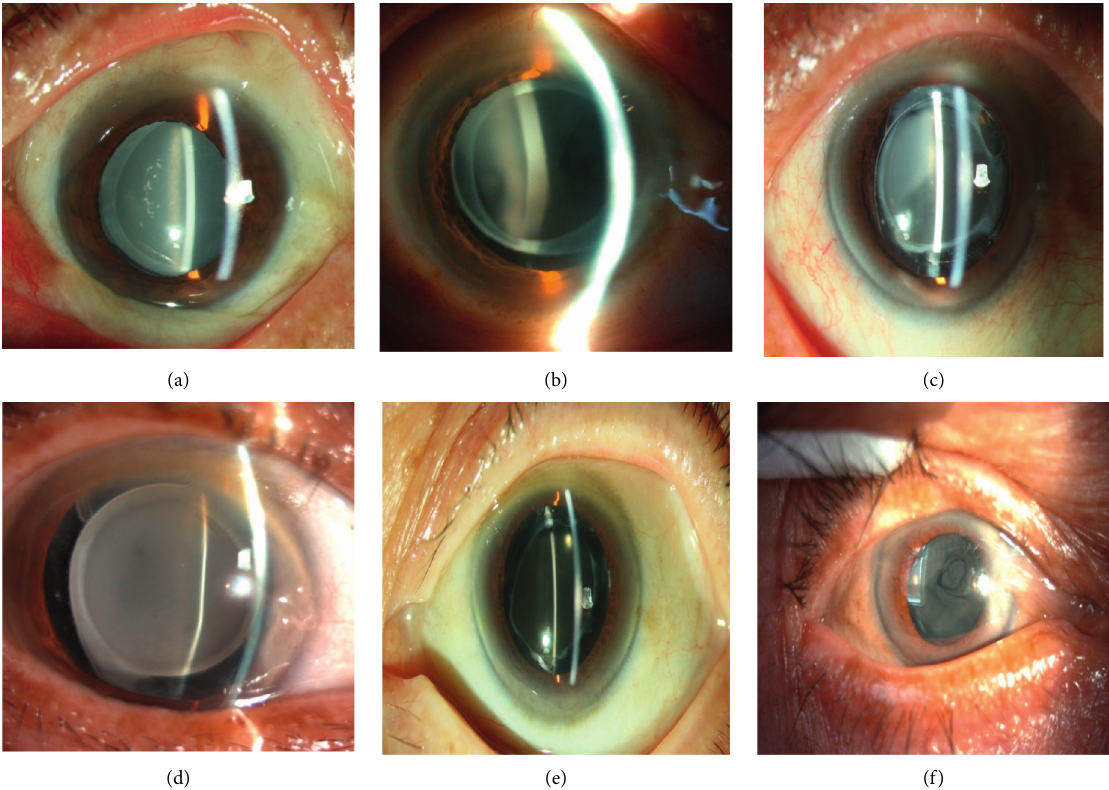
Figure 1: Photographs of the distinct case of IOL opacification. (a)–(e) The postoperative opacification was 860UV IOLs, (f) the opa- cification IOL was L-312.